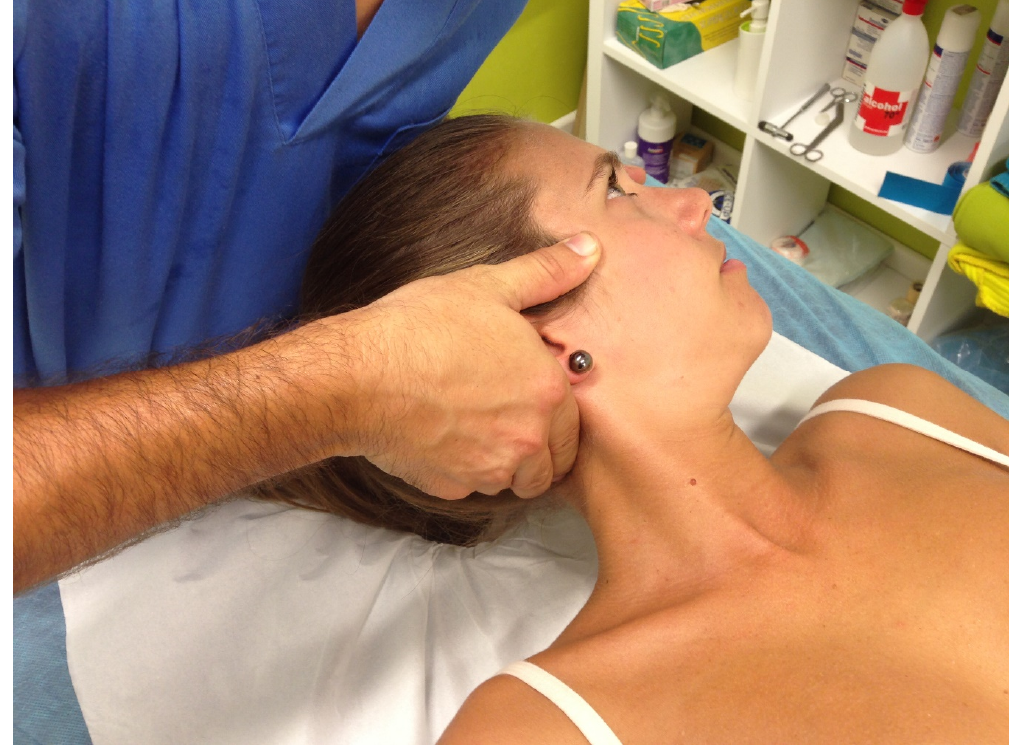
Figure 2. Upper cervical spine (C1-C2) high-velocity, low-amplitude (HVLA) rotational thrust manipulation for a restricted left rotation with positive cervical flexion-rotation test (CFRT).